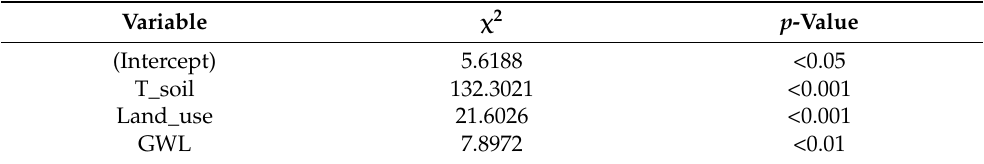
Figure 3. The linear mixed-effect model’s estimated and the actual CO 2 -C flux. Table 5. The linear mixed-effect model of CO 2 -C flux variable significance (model coefficients presented in Table S1).